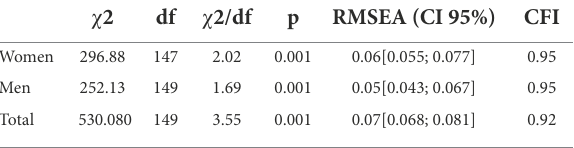
TABLE 3 Model fit indices of total, female and male